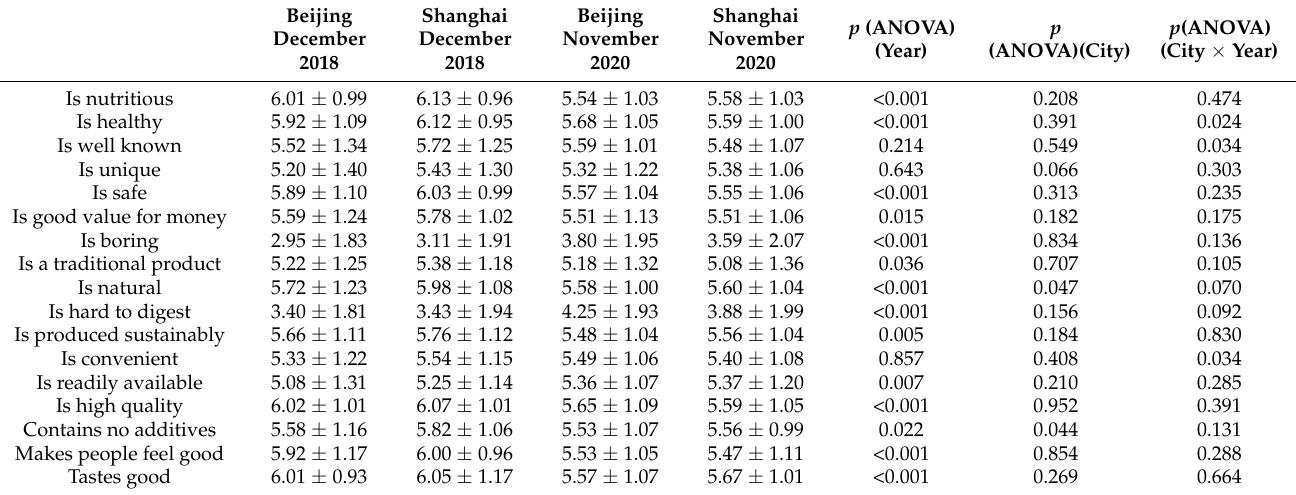
Table 5. Opinion of New Zealand lamb (1 = strongly disagree, 7 = strongly agree) (mean ± SD) ( p value determined using a two-way ANOVA with year and city as the main effects).